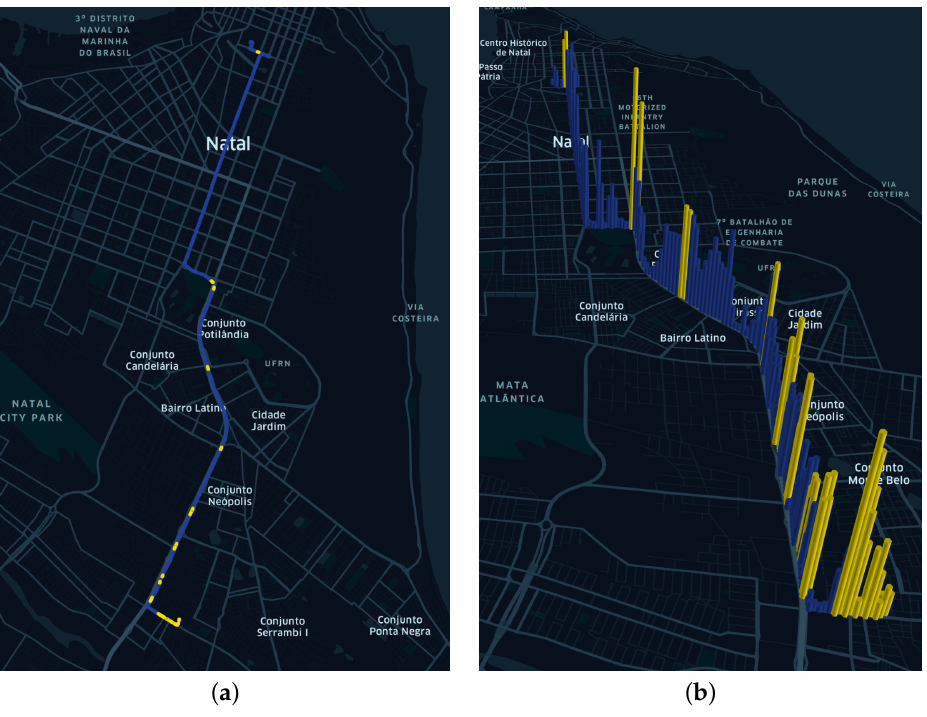
Figure 8. Application of the TEDA algorithm on the Monday dataset using m = 1.5. ( a ) Geographical arrangement of outliers (yellow marker). ( b ) Magnitude of CO 2 values along the